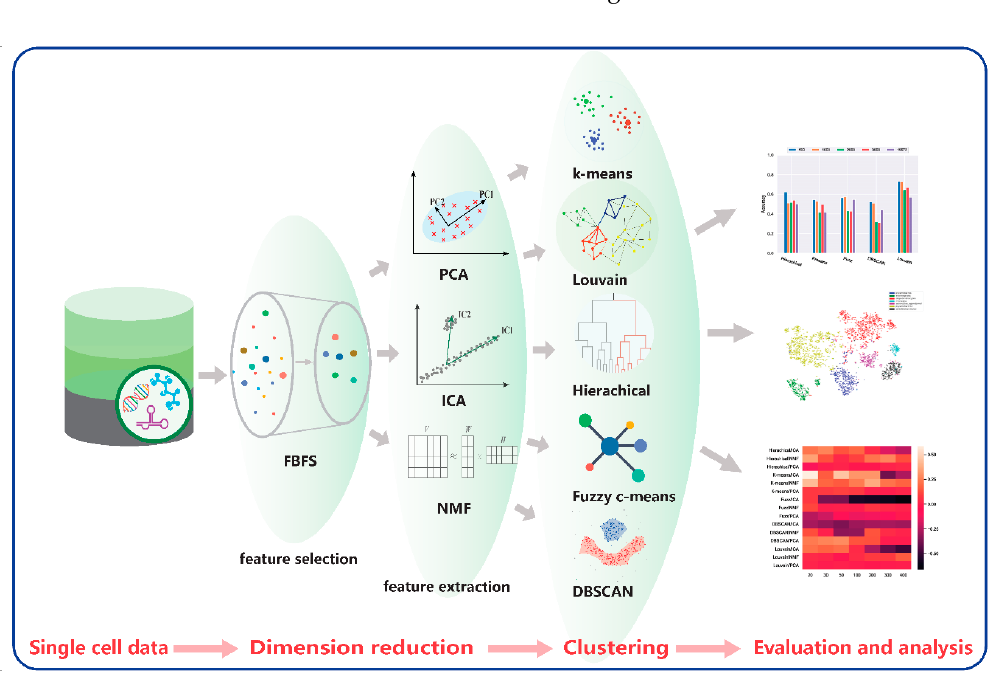
Table 2. Combinations of dimensionality reduction and clustering models.